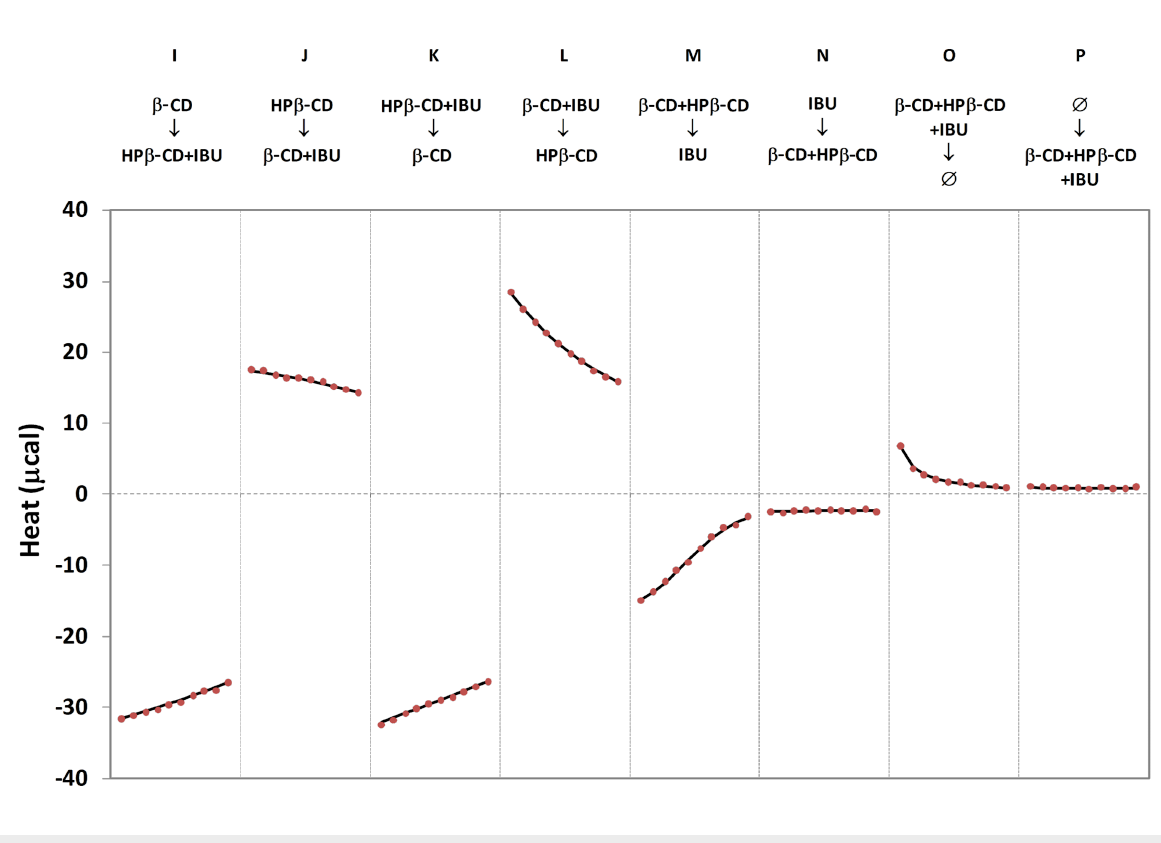
Figure 4: Competitive ITC isotherms for the HP β -CD- β -CD-IBU system at 283 K. Each protocol (from I to P) is defined by the respective content of syringe (top) and cell (bottom). Ø indicates the buffer solution. Lines and dots correspond to theoretical and experimental data, respectively. The x axis corresponds to the injection number (10 injections per